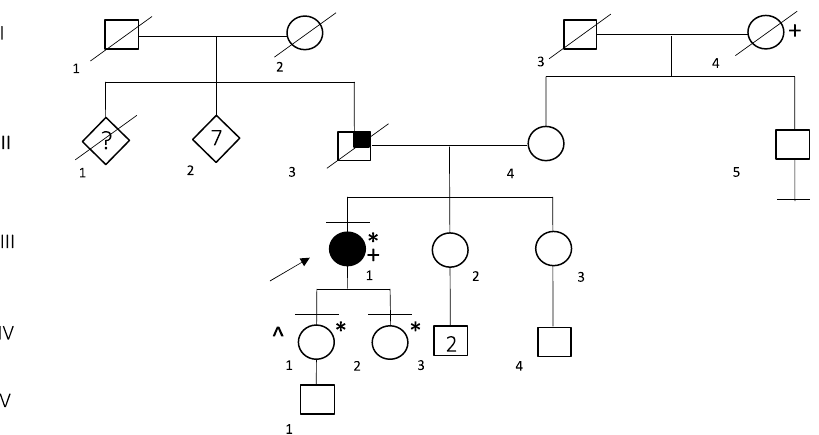
Figure 2. Family Pedigree of Patient ID 6. Black circle and squares indicate individuals with Arrhythmogenic cardiomyopathy. Black arrow indicates the proband. Black lines at the top indicate individuals who underwent to genetic testing. Black lines at the bottom indicate individuals without offspring. Little black square indicates lung cancer, * E1068Vfs*19 heterozygous carrier, + Breast cancer, ^ Bilateral hypoacusia, probably due to a meningitis infection on her 6th month of life.